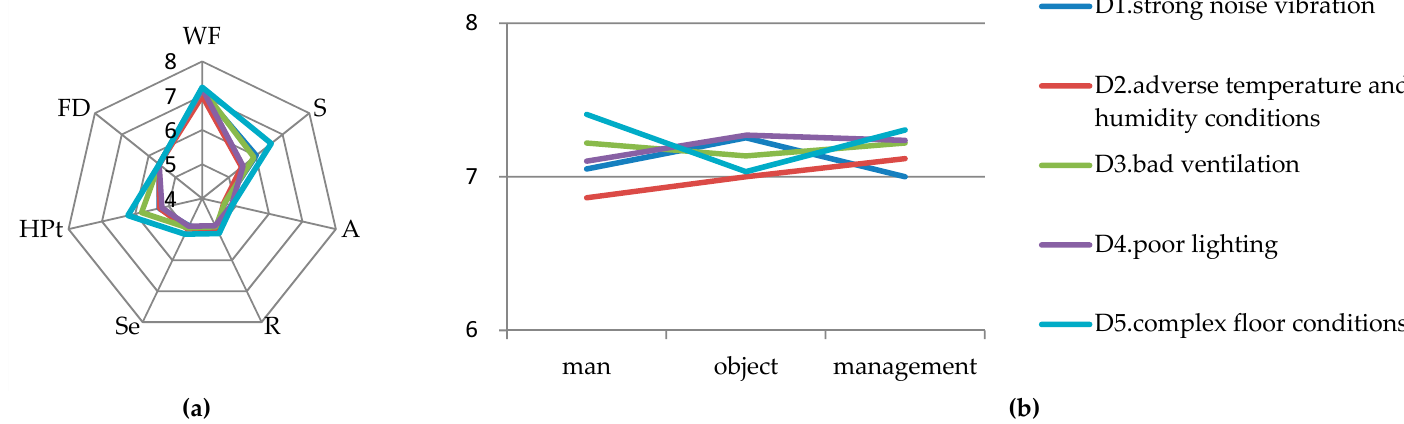
Figure 4. ( a ) Parameters scores for laboratory environment; ( b ) detailed scores of WF for laboratory environment.